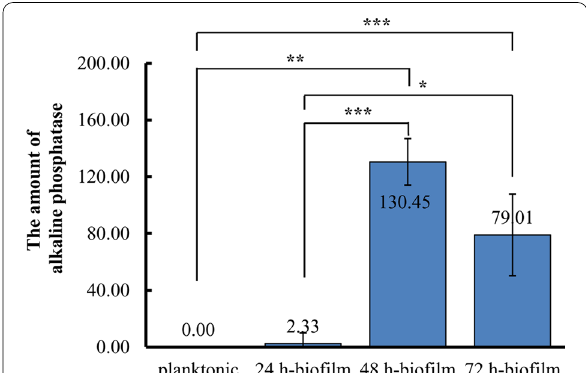
Fig. 5 The amount of alkaline phosphatase measured in the supernatants from P. aeruginosa PAO1 at biofilm and planktonic states, respectively. The amount of alkaline phosphatase was defined as the µmoles of p -nitrophenol liberated from p -nitrophenyl phosphate at the specific time and the data was normalized to log 10 CFU. Data were collected from three independent experiments with at least three replicates each. Error bars represent the standard deviation from three independent experiments. P values that are significantly different by T.test are indicated by asterisks as follows: *, P < 0.05; **, P < 0.01; ***, P < 0.001